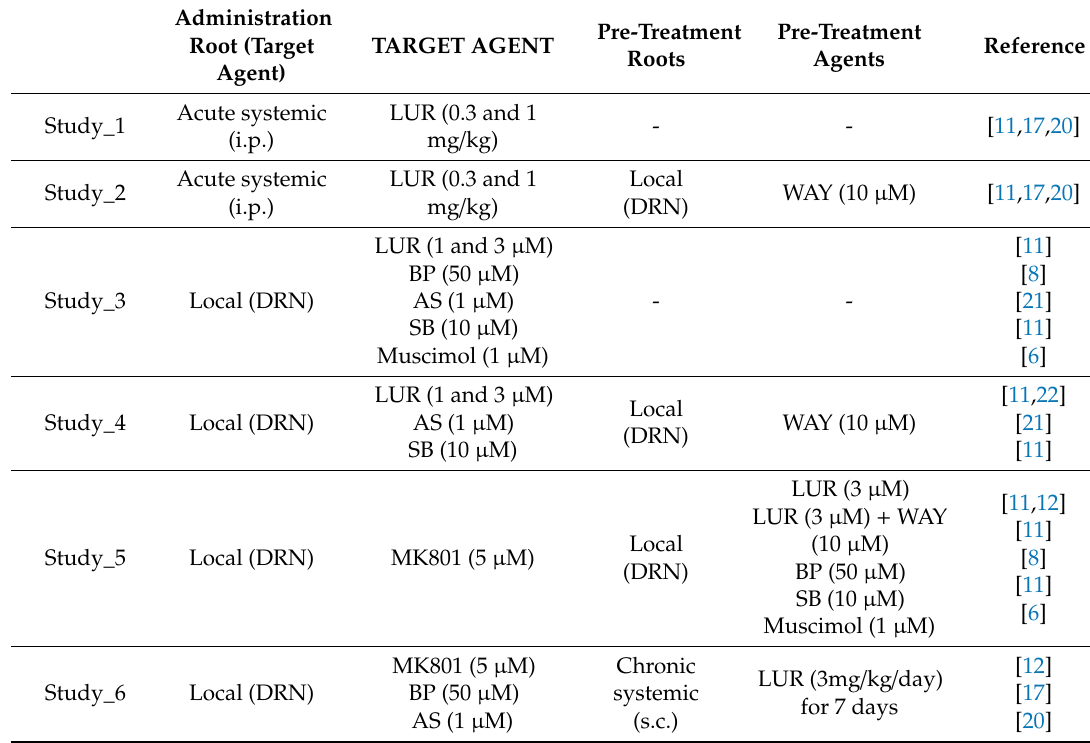
Table 1. Summary of study